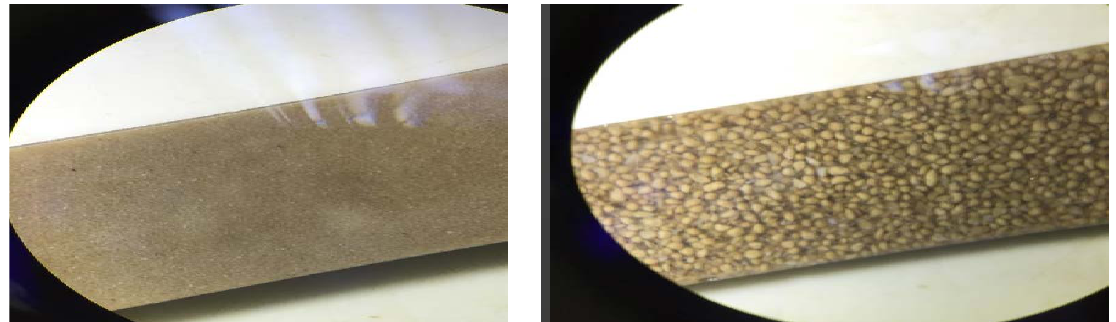
Figure 13: Optical microscope image of cockle shell particle epoxy composite with size in (a) Range 1 (